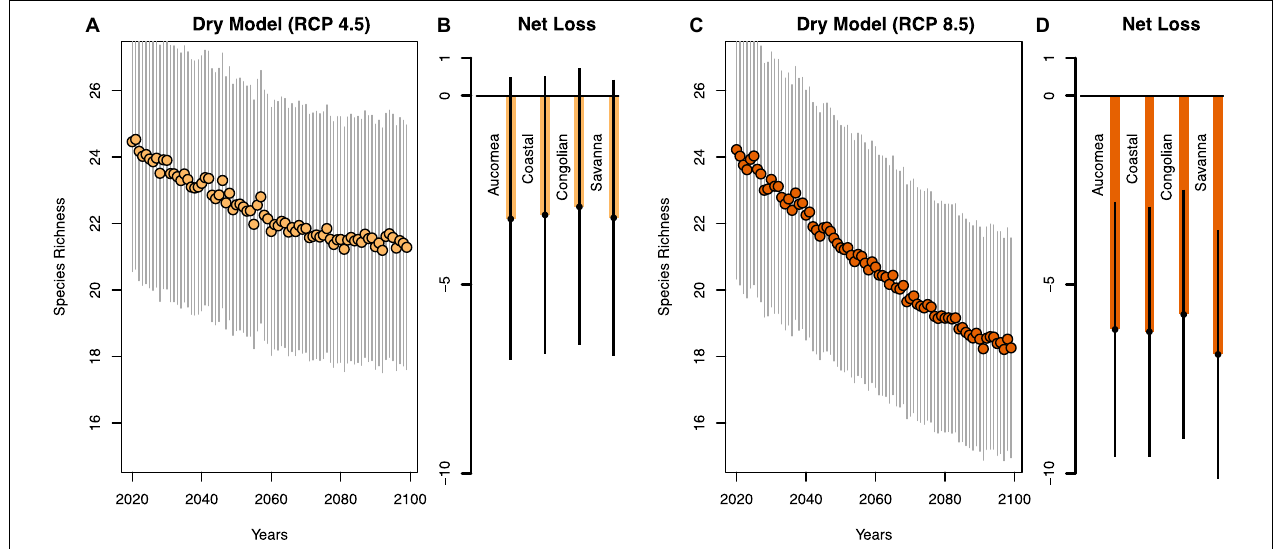
FIGURE 4 | Declines in estimated plot-level species richness and the estimated net tree species loss for each for each forest type by the end of the century for RCP 4.5 (A,B) and RCP 8.5 (C,D) for the Dry model.